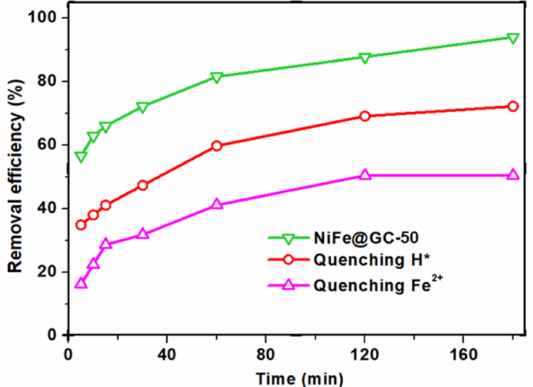
Figure 8. Quenching effect of reducing species (H*/Fe 2+ ) on Cr(VI) removal. (Experimental conditions: TCP = 30 mg L − 1 , pH = 3.0, dosage = 1.0 g L − 1 , Tert-butyl alcohol = 0.15 M, 1,10- Phenanthroline = 0.15